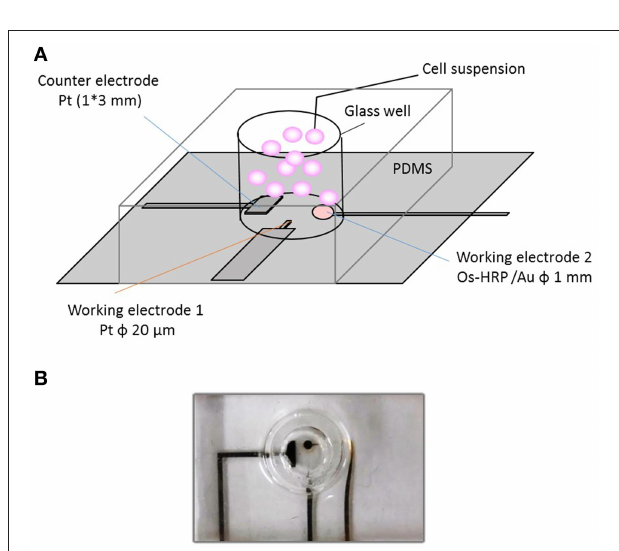
FIGURE 1 | Experimental setup of catalytic amperometry using newly developed chip-type electrochemical biosensor device. The setup illustrated shows (A) ; the schematic representation of the chip-type device showing the counter electrode, CE; working electrode 1, WE1 (Pt microelectrode) and working electrode 2, WE2 (Os-HRP modified Au electrode) (B) ; photograph of the chip-type device showing the glass well consisting of